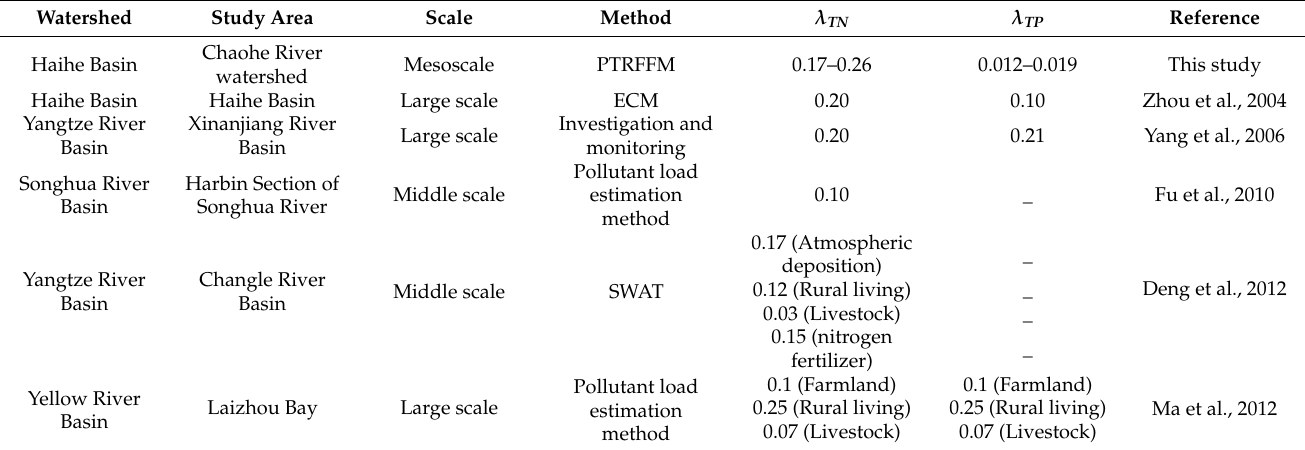
Table 5. Results of the other studies on the path-through rate of NPS pollutants in China. Watershed